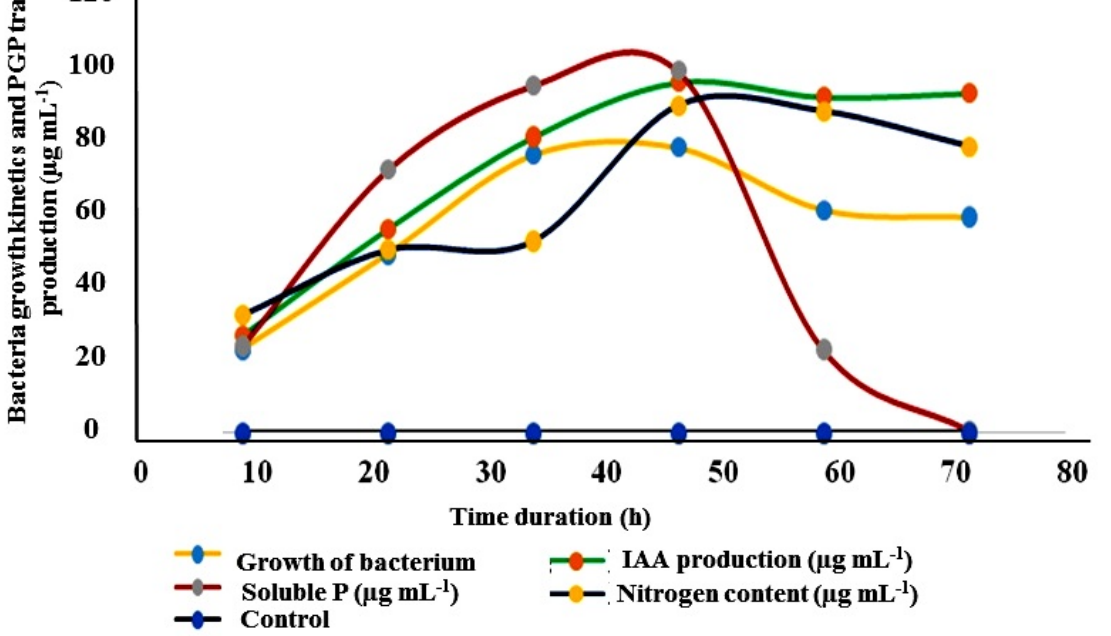
Figure 4. Growth kinetics, IAA, nitrogen production, and soluble phosphate (solubilization) produced by Kosakonia sp. MGR1 under optimized conditions.